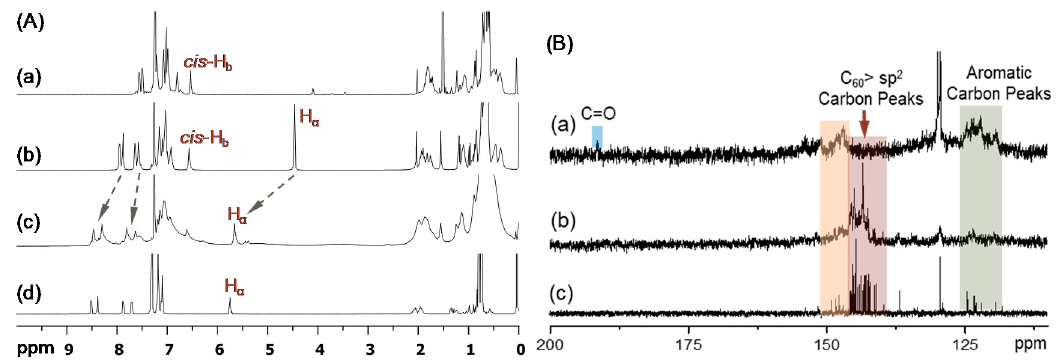
Figure 2. ( A ) 1 H NMR spectra (CDCl 3 ) of (a) cis ‐ cup ‐ tris(DPAF ‐ C 9 ) ( cis ‐ cup ‐ 2 ‐ C 9 ), (b) cis ‐ cup